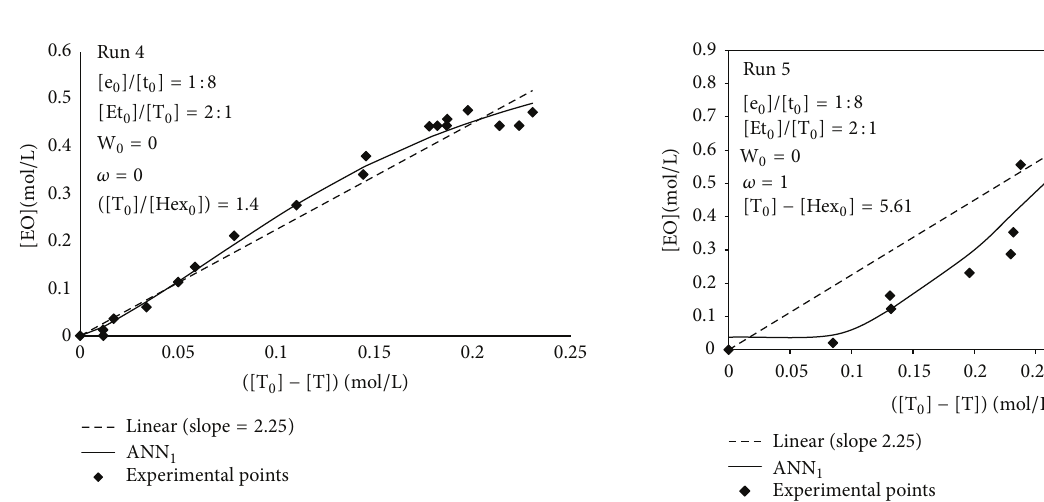
Figure 3: Comparison between experimental data, ANN 1 pre- diction, and linear empirical correlation ([EO] = 2.25 ∗ ([T 0 ] − [T]) exploited in [12], for the determination of the relationship between ethyl oleate production and triolein consumption. Operating condi- tions: run 5 of Table 1.